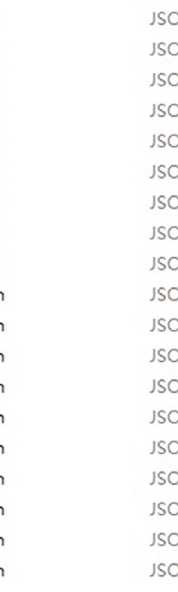
Figure 6: The JSON fi le